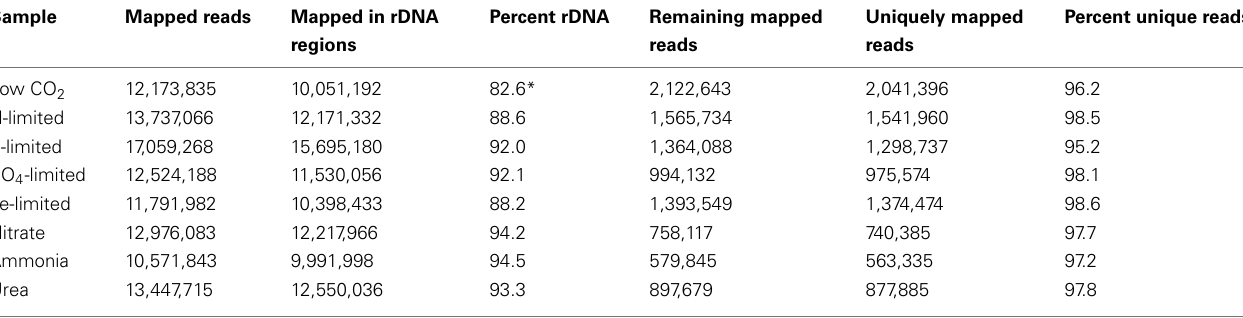
Table 1 | Number of sequences obtained by SOLiD™ sequencing for the samples analyzed in this study. Sample Mapped